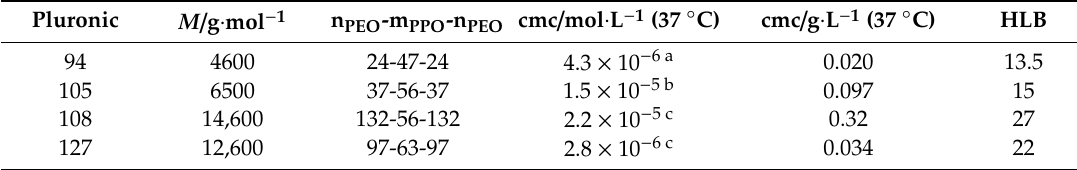
Table 1. Main properties of the applied